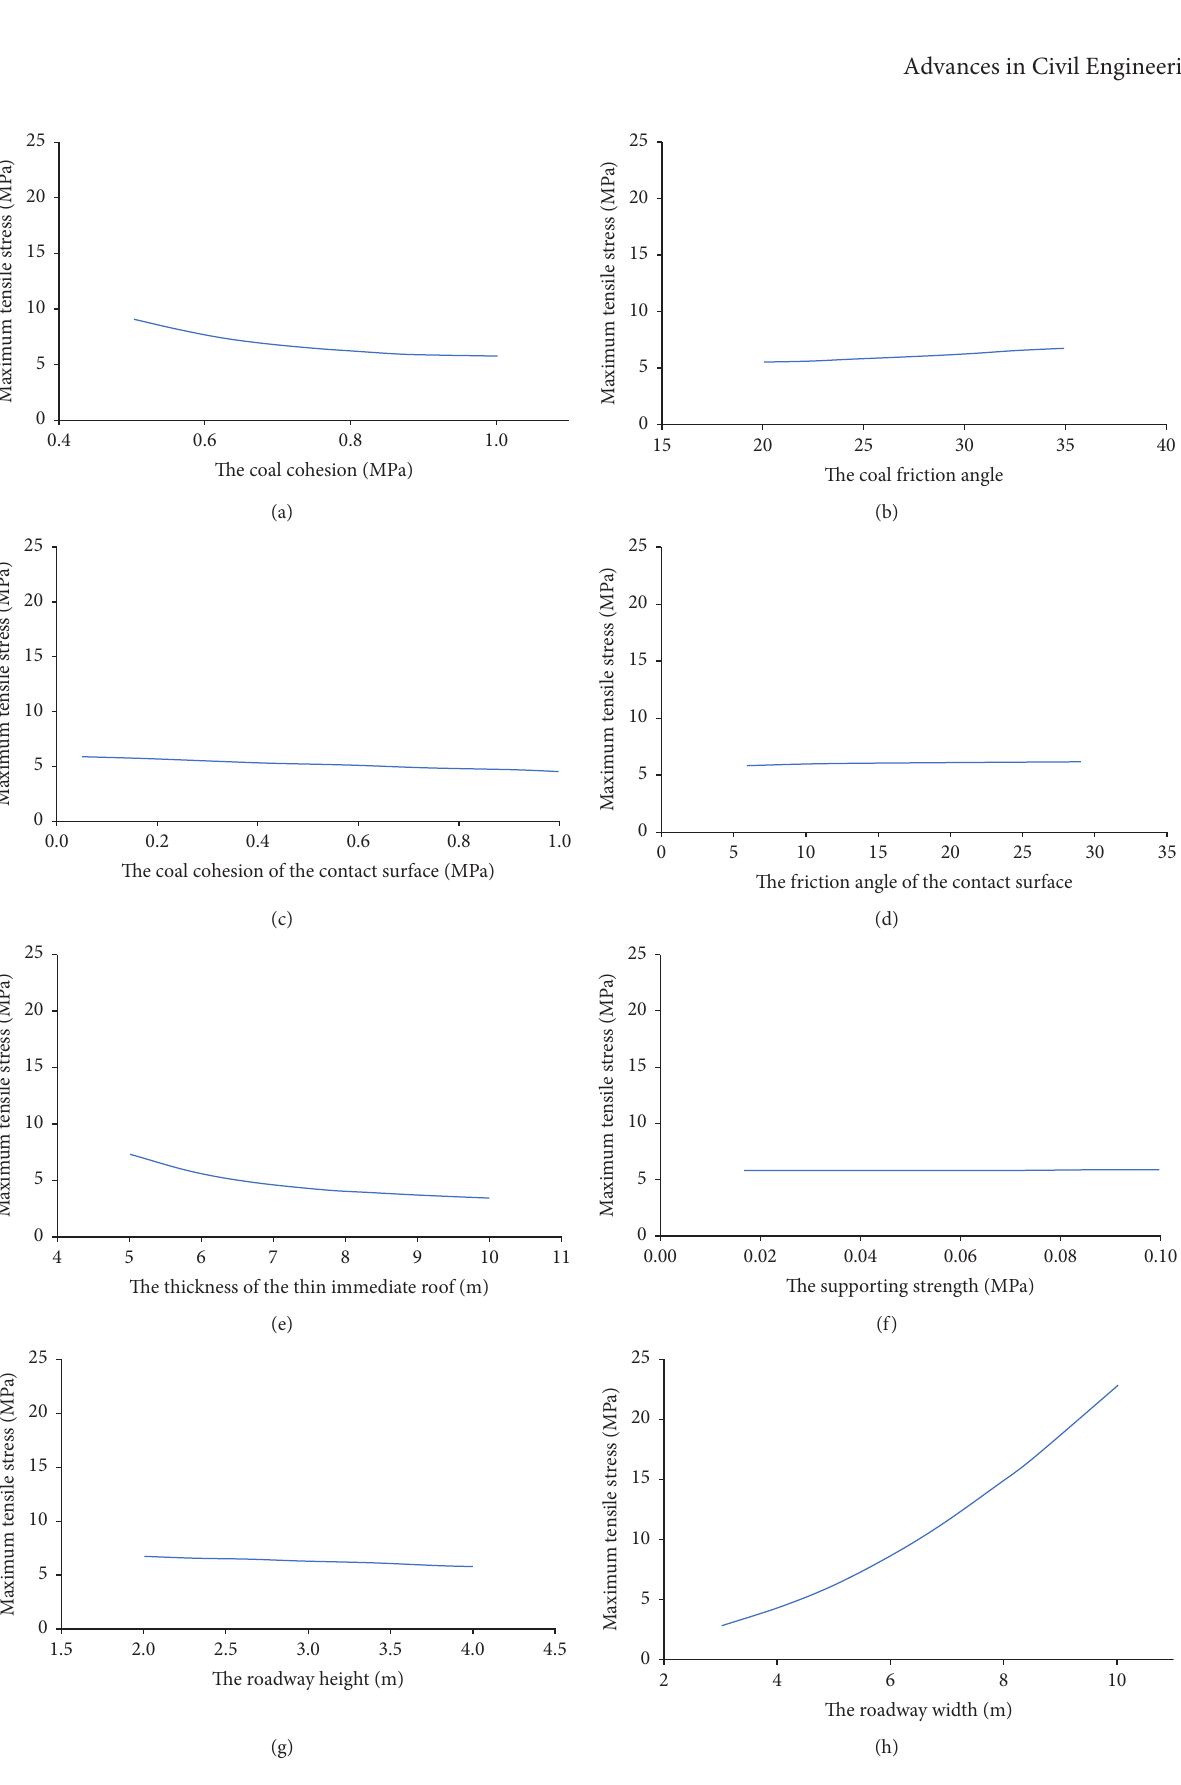
Figure 12: Parameter analysis of maximum tensile stress of thin immediate roof under uniform load. (a) The coal cohesion. (b) The coal friction angle. (c) The coal cohesion of the contact surface. (d) The friction angle of the contact surface. (e) The thickness of the thin immediate roof. (f) The supporting strength. (g) The roadway height. (h) The roadway